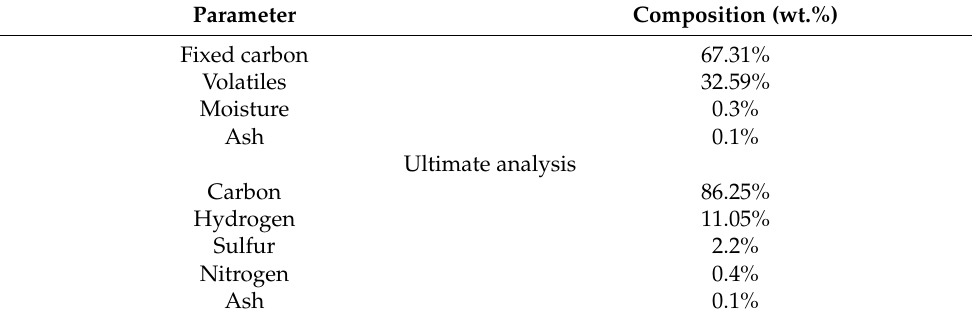
Table 1. Heavy oil characterization on dry basis [18,24].